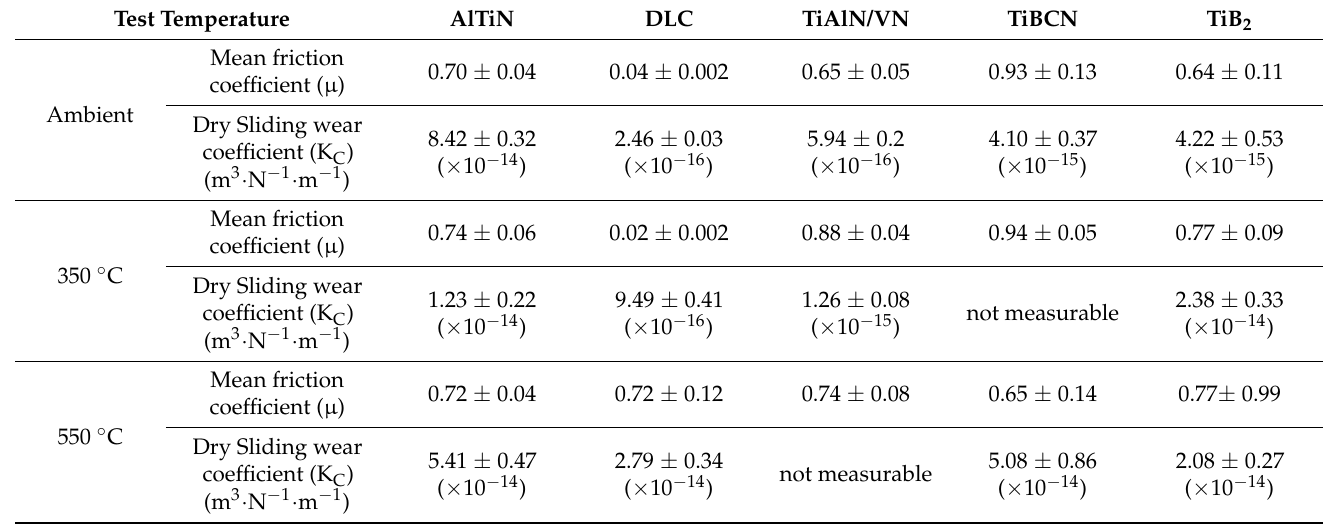
Table 2. Mean friction coefficients and dry sliding wear coefficients for different coatings according to test temperatures.